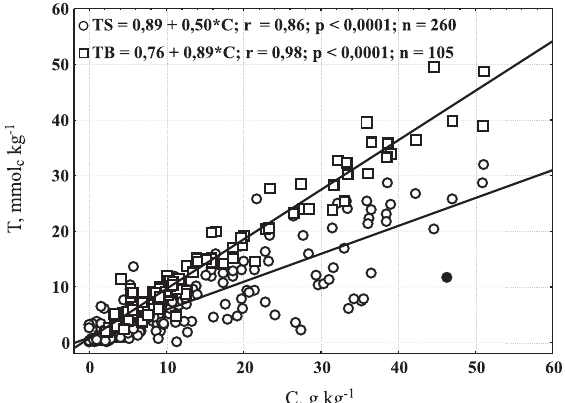
Figura 2. Relação entre a capacidade de troca de cátions (T) e o carbono orgânico (C). TS refere- se a todos os horizontes e perfis estudados; TB, apenas aos horizontes